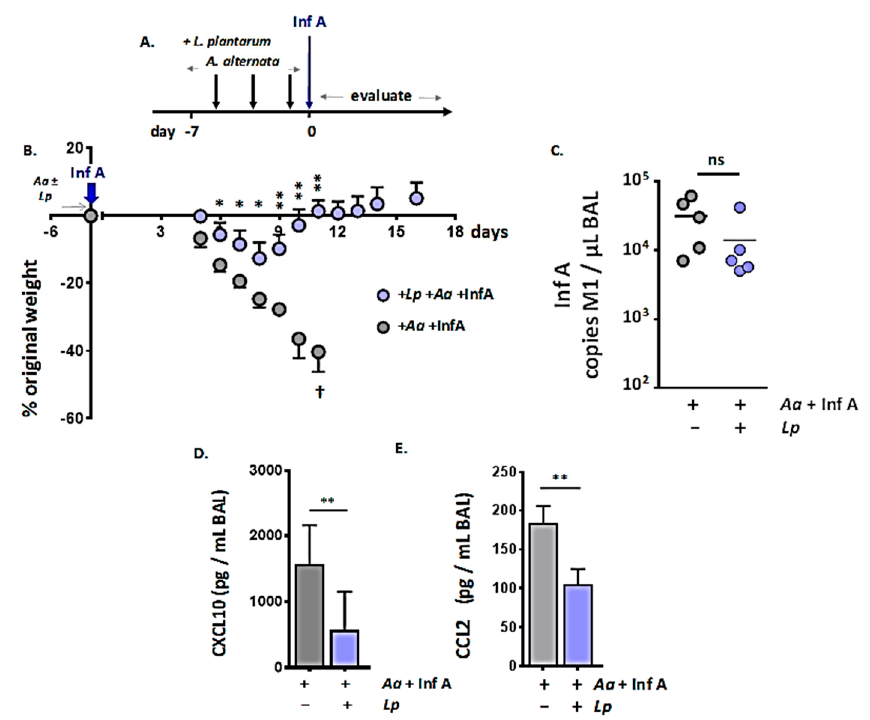
Figure 5. Administration of immunobiotic Lactobacillus plantarum directly to the respiratory mucosa protects against the lethal response to Inf A. ( A ) Strategy: repetitive administration of A. alternata (days − 5, − 3 and − 1; 2.5 µ L per nare, 5 µ g per inoculum) immediately preceded (10–15 min) by L. plantarum (10 8 CFU in 50 µ L phosphate-bu ff ered saline [PBS] with 0.1% bovine serum albumin [BSA]) or diluent control. On day 0, mice were inoculated with Inf A. ( B ) Administration of L. plantarum protects against increased susceptibility to lethal Inf A; n = 5 mice per group, * p < 0.05; ** p < 0.01, † no survival after this time point in the group indicated. ( C ) Virus titer (copies per µ L BAL fluid) on day 8 in mice challenged with A. alternata as in Figure 5A both with and without L. plantarum ; ns, no significant di ff erence. ( D ) CXCL10 (pg / mL BAL fluid) and ( E ) CCL2 (pg / mL BAL fluid); day 8 as per Figure 5A; n = 5 per group, ** p < 0.01, Mann–Whitney U-test.